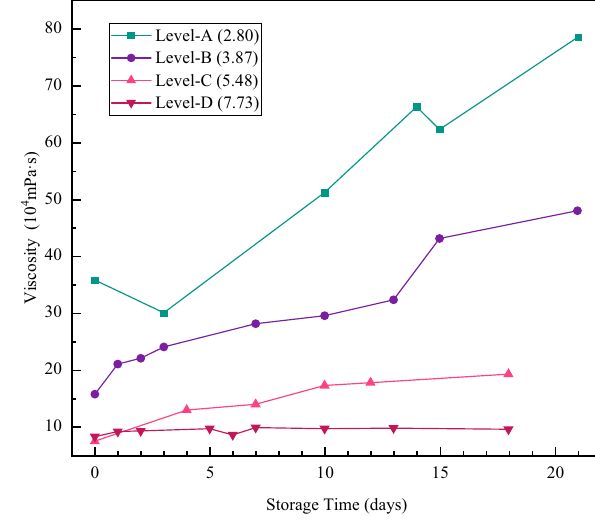
Figure 4: Viscosity change of RTV compositions prepared with dif - ferent grades of hydrophobic silica samples.